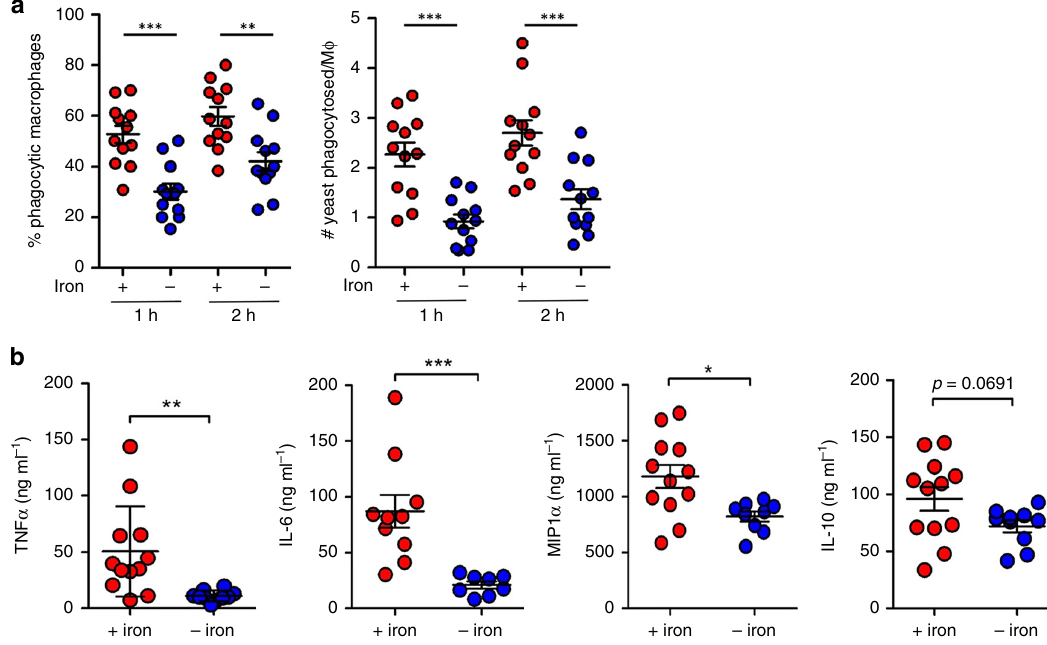
Fig. 5 C. albicans adaptation to iron limitation attenuates immune responses. Wild type C. albicans cells (SC5314) were exposed to iron replete (red) or iron-